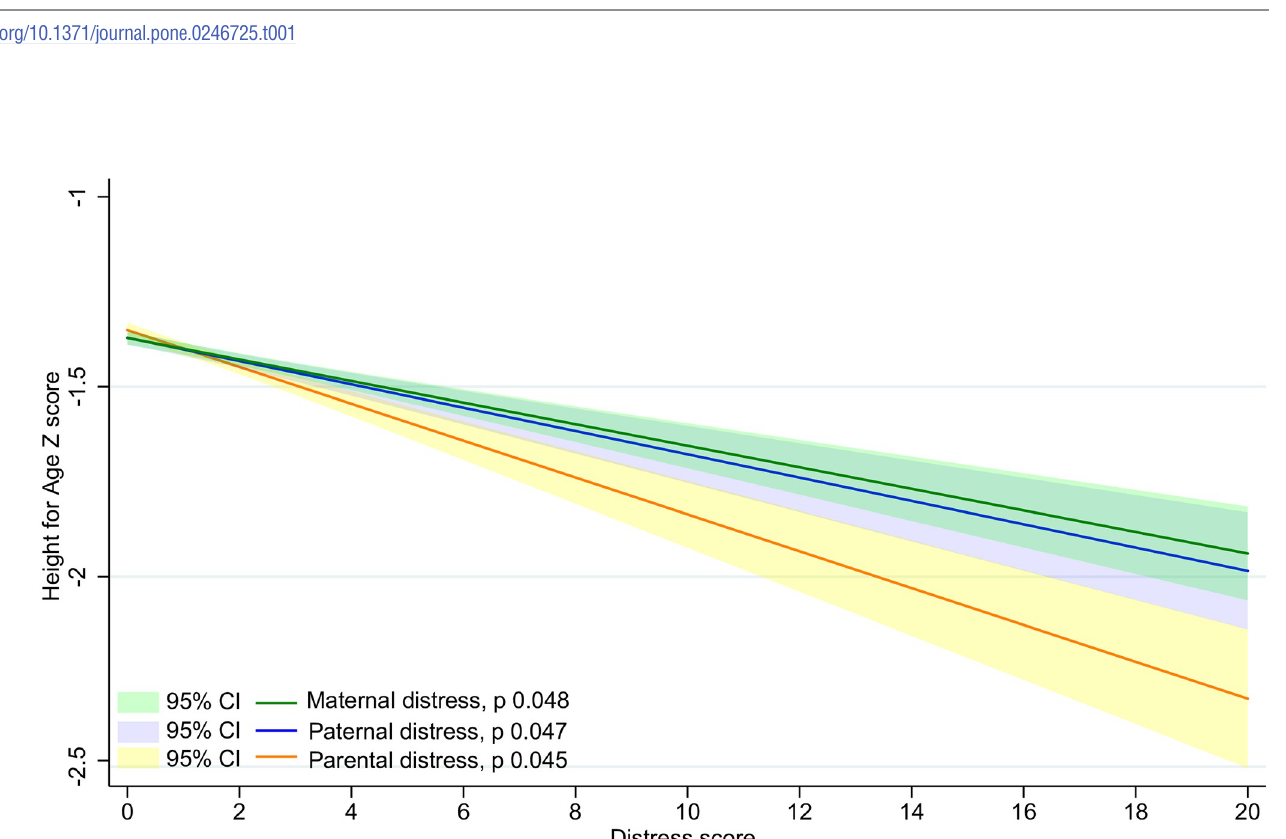
PLOS ONE | https://doi.org/10.1371/journal.pone.0246725 October 26,